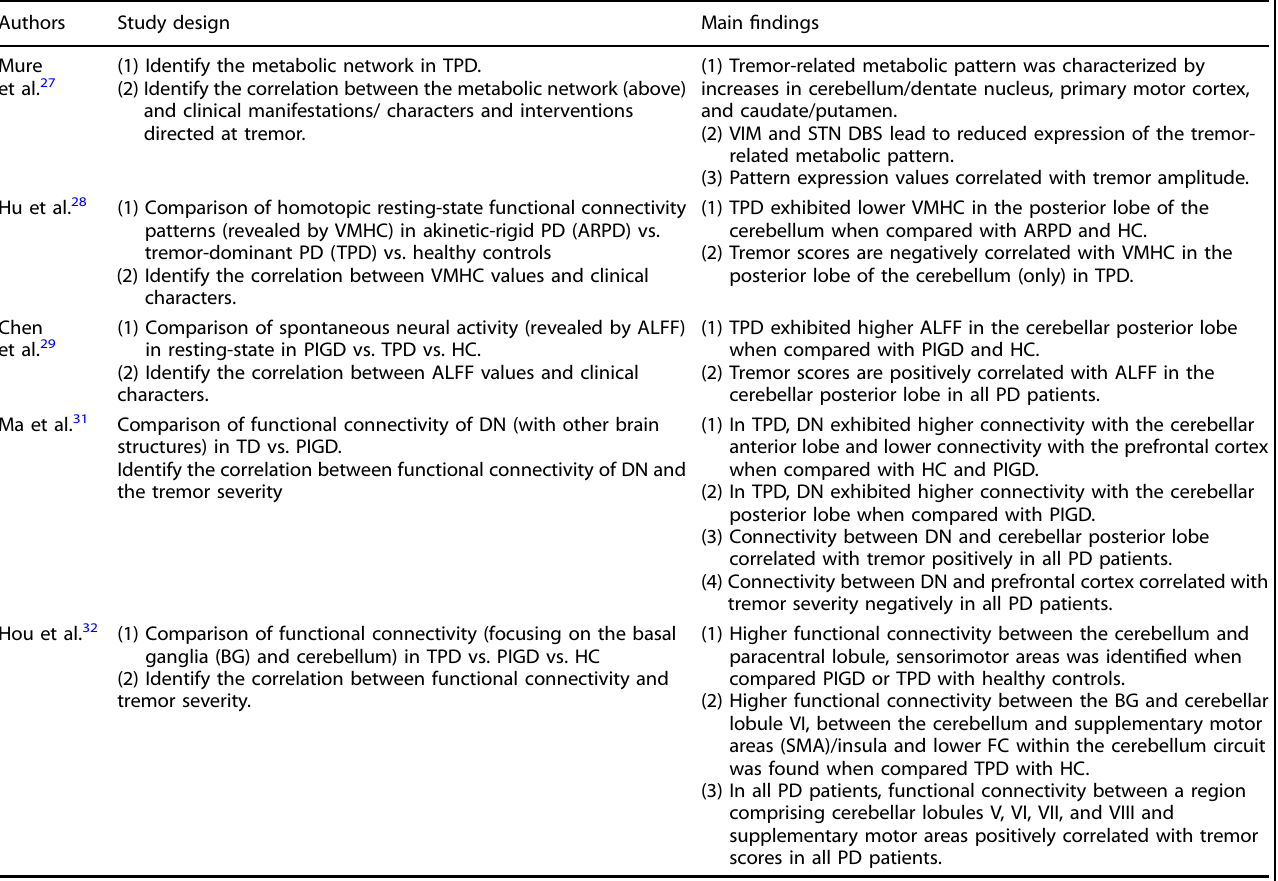
Table 2. Functional imaging studies reporting on tremor and cerebellum in Parkinson ’ s